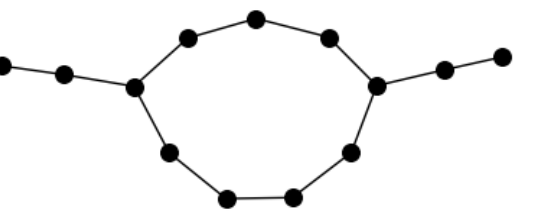
Figure 3. The unicyclic graph on 13 vertices and with odd cycle that has Wiener complexity smaller than eccentric